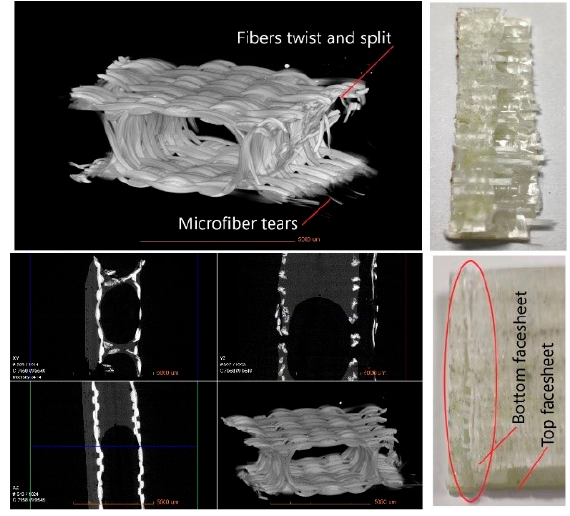
Figure 19. X-ray computed tomography image of the fractured tensile specimen.